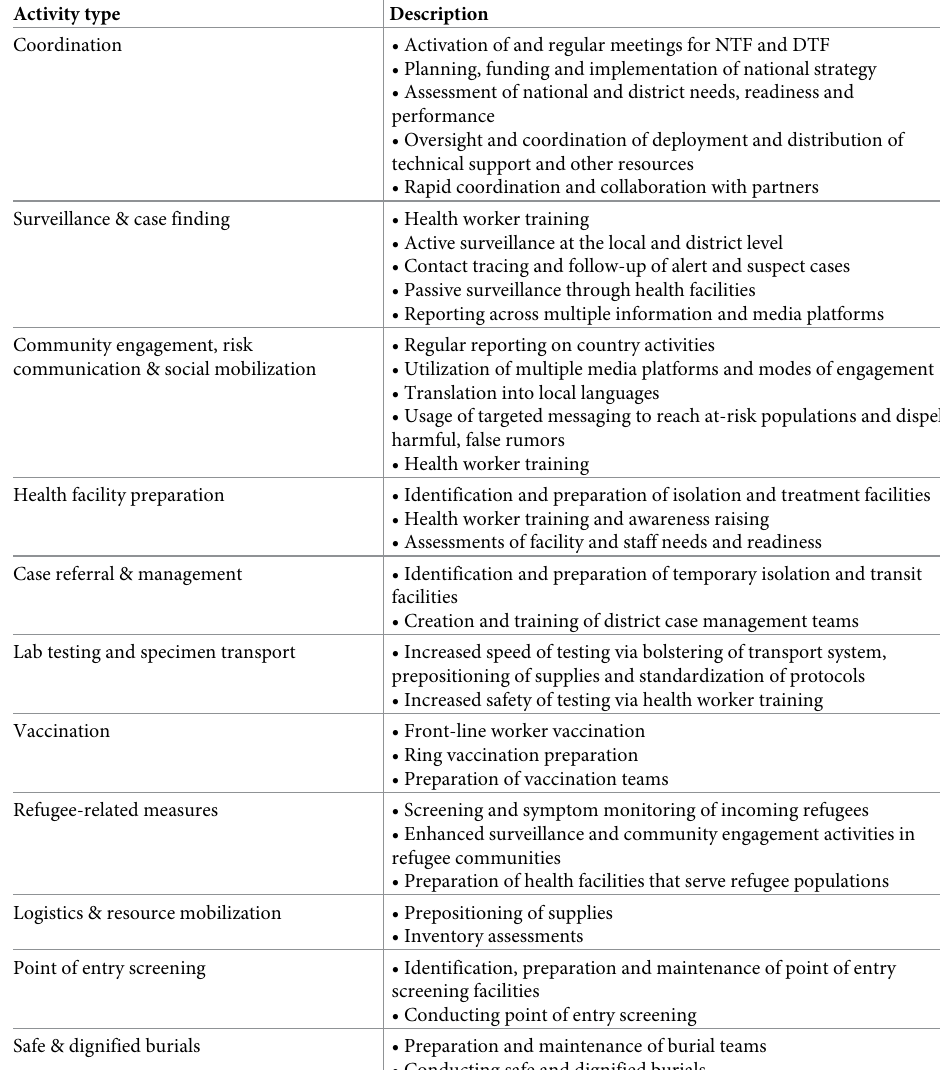
Table 1. Preparedness framework by activity